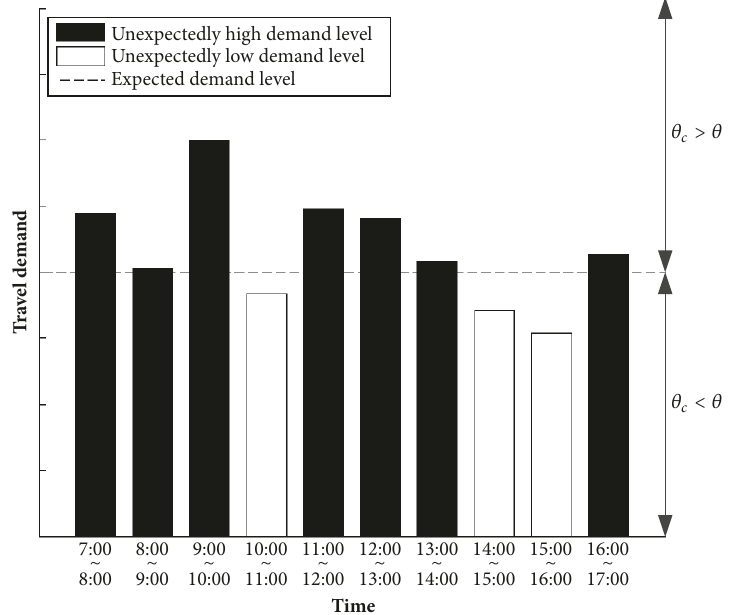
Figure 3: Uncertainties in travel